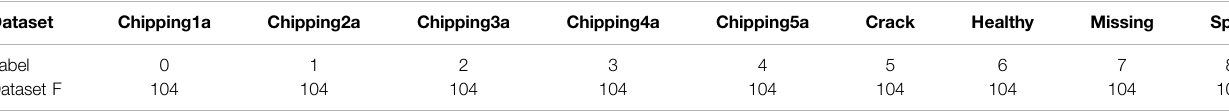
TABLE 5 | Time-frequency images dataset of University of Connecticut gearbox.